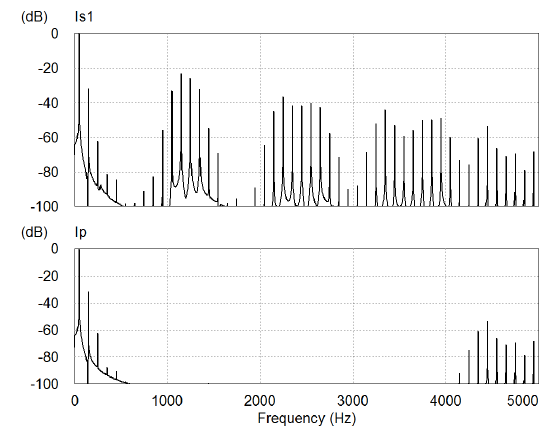
Figure 13. Secondary and primary currents frequency spectrum showing harmonic cancellation. Traces: Is1 - AC current of converter 1, Ip - primary